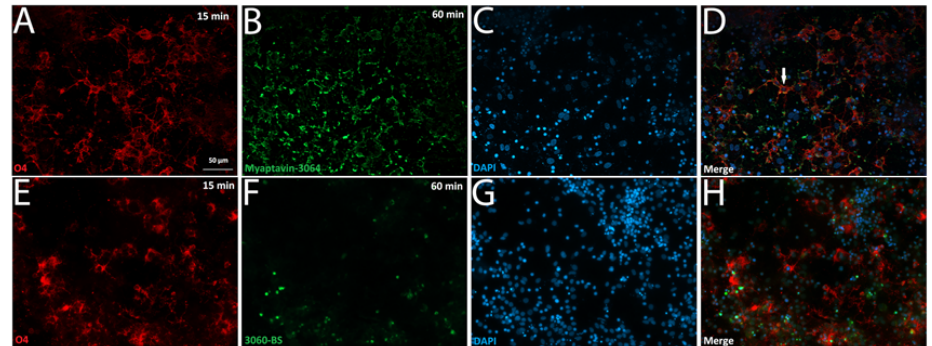
Figure 4. Aptamer conjugate binding to adult rat oligodendrocytes. Mixed glial cells obtained from adult rat brain tissue were grown on laminin ‐ and poly ‐ ornithine ‐ coated cover slips for three weeks. Live staining was performed on unfixed cells after incubation for 15 min with O4 ( A , E ), DAPI ( B , F ) and for 60 min with Myaptavin ‐ 3064 ( C , D ) or 3060 ‐ BS ( G , H ). Most O4 ‐ positive OLs were positive for Myaptavin ‐ 3064 binding ( C , D ), whereas minimal binding was observed for negative control aptamer conjugate 3060 ‐ BS ( G , H ). The white arrow in ( D ) indicates an example of co ‐ localization of O4 (red) and Myaptavin ‐ 3064 (green) on adult rat oligodendrocytes (OLs).